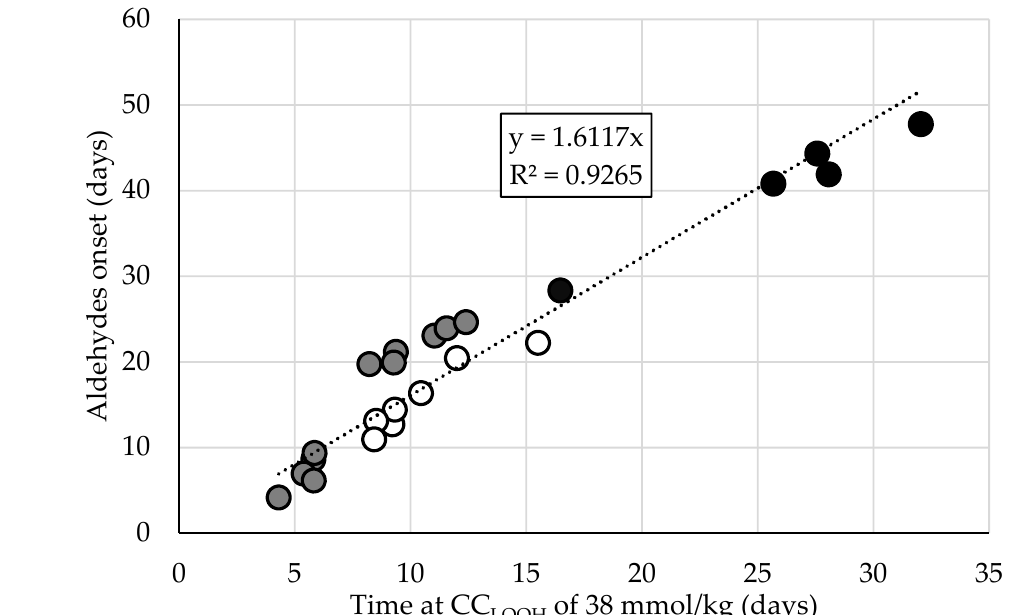
Figure 2. Dependencies between the time after which the CC LOOH was reached and the onset of the corresponding aldehyde curve. Different colors represent the different oil contents in the mayonnaises (set A (65% rapeseed (RP)) black; set B (75% RP) white; set C (78% RP) gray). ( A ) Time differences between the moment CC LOOH was reached and the aldehyde onset ( ∆ t CC-AO ), where every bar represents a formulation within the mayonnaise set. ( B ) Linear regression model with the time at CC LOOH as regressor and aldehyde onset as predictor, where every circle represents a formulation within the mayonnaise sample set.